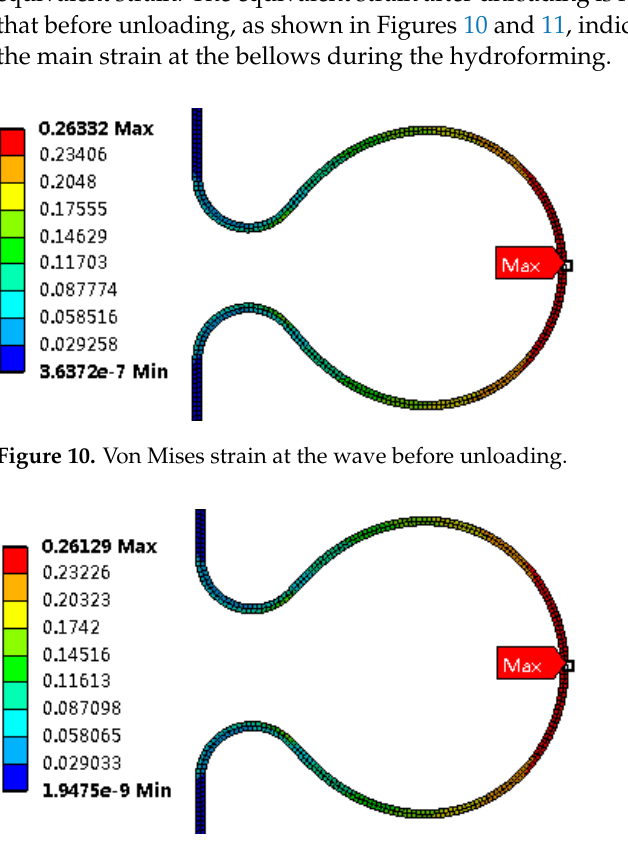
Figure 9. Von Mises equivalent stress distribution after unloading (MPa).